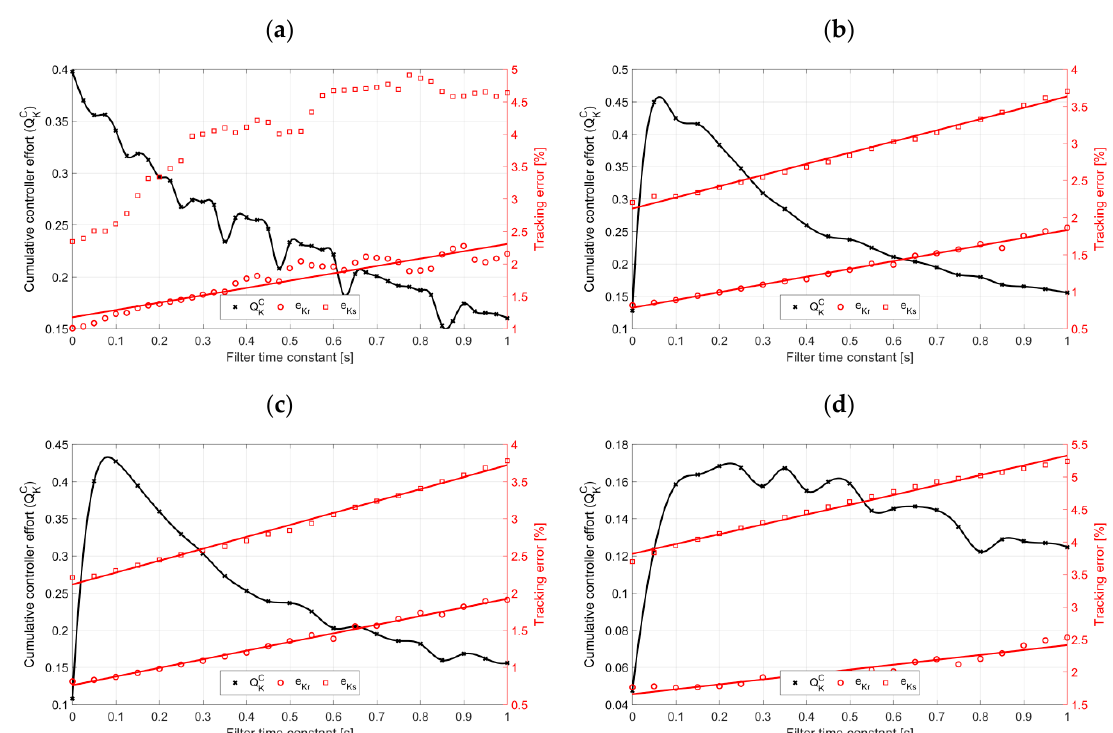
Figure 21. Cumulative effort and tracking errors e Kr and e Ks versus filter time constant for: ( a ) P controller, ( b ) PD controller, ( c ) FPD controller, and ( d ) NN controller.